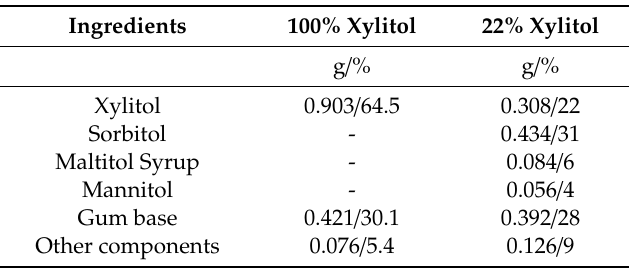
Table 1. Percentage Composition of the two chewing gums. Each chewing gum weights 1.4g.